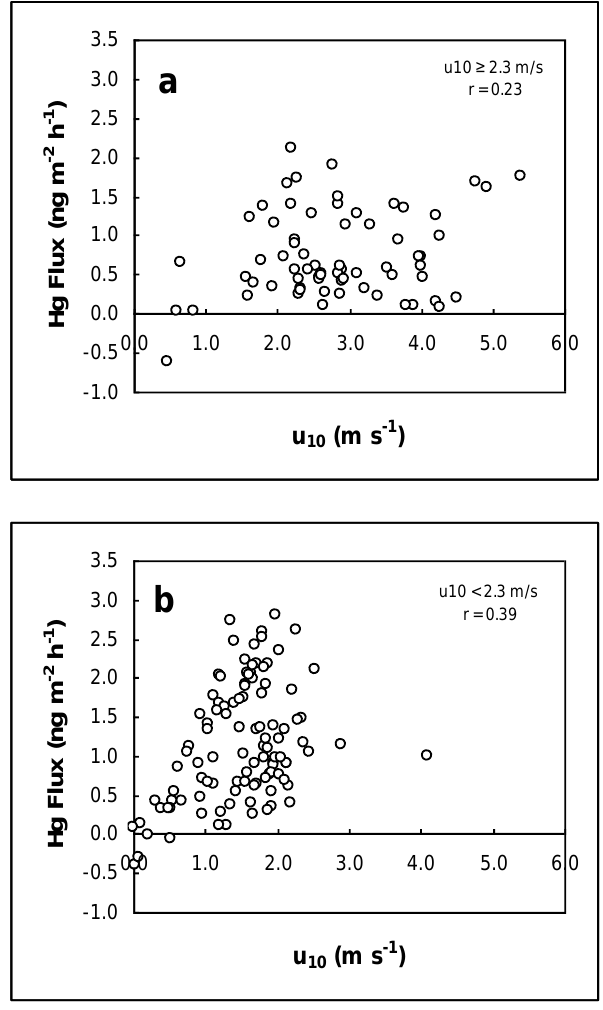
Figure 7. The correlation between Hg air / water exchange flux and wind speed ( u 10 ) for all the data with the daily mean wind speed ( a ) ≥ 2.3 m s − 1 ( r = 0.23) and ( b ) < 2.3 m s − 1 ( r = 0.39).